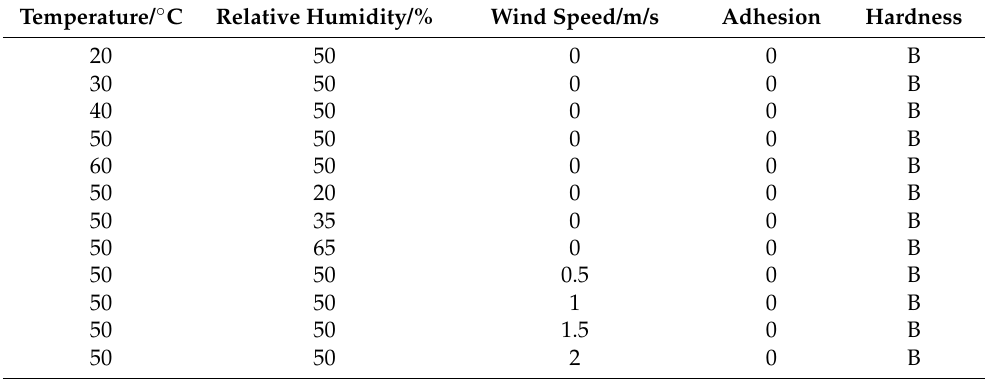
Table 3. Adhesion and hardness of the paint film under different environmental conditions.